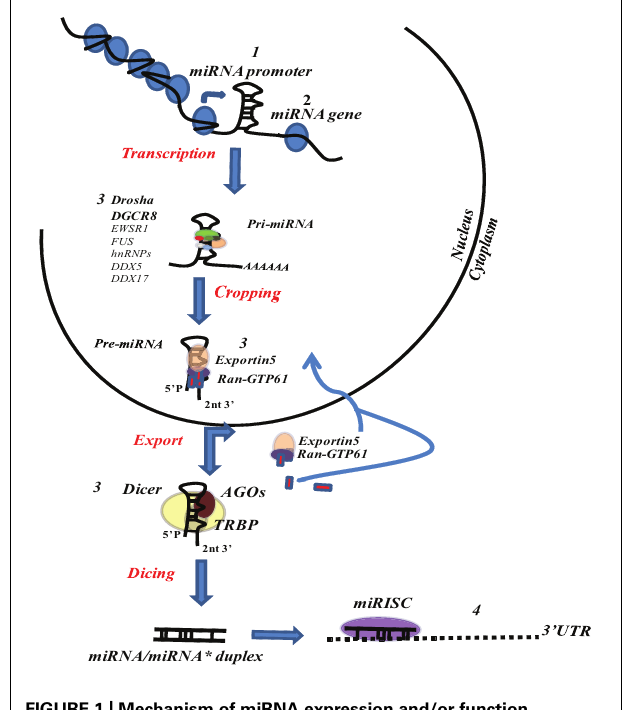
FIGURE 1 | Mechanism of miRNA expression and/or function perturbation. (1) Epigenetic changes (DNA methylation and histones modifications);Transcription factor or regulatory gene alteration. (2) Genomic changes (deletions, amplifications, translocation, SNPs, mutations). (3) Functional or expressional biogenesis pathway alterations (Drosha down-regulation; XPO5 mutation; DISC assembly defects). (4) Alteration of target mRNAs 3 (cid:2)